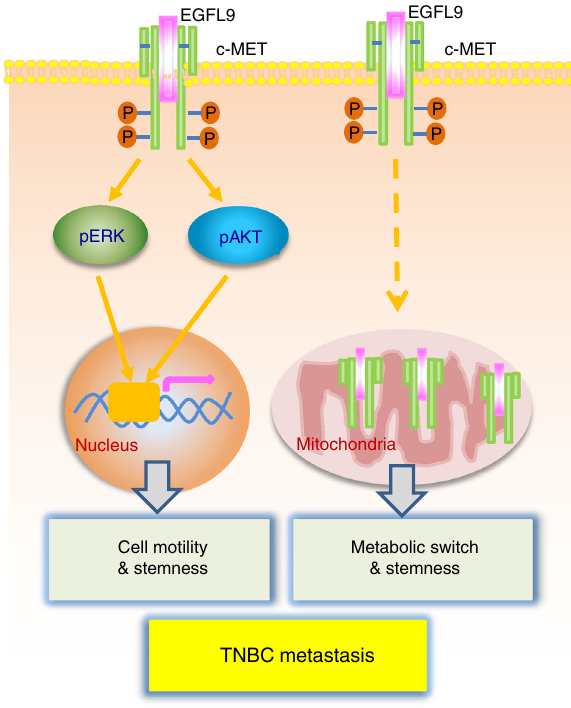
Fig. 9 Schematic illustration of the EGFL9 in driving TNBC